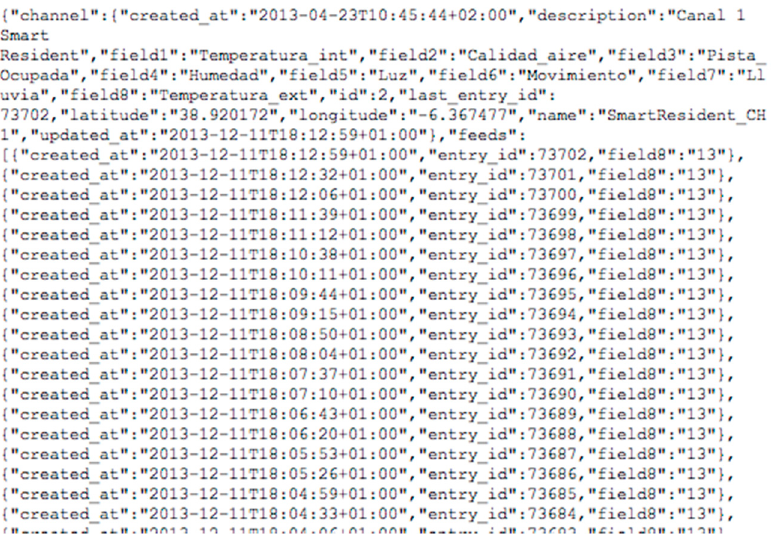
Figure 10. JSON data to graph Figure 9.